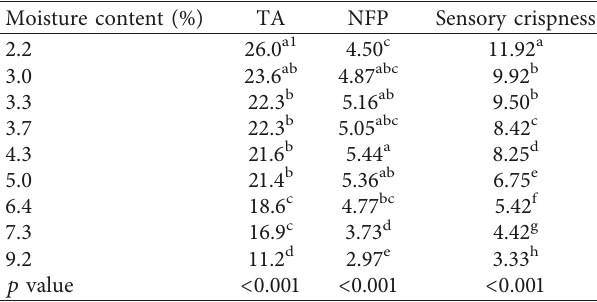
Table 2: Mean values of total area (TA) and number of force peaks (NFP) by texture analyzer and sensory crispness of potato chips having different moisture